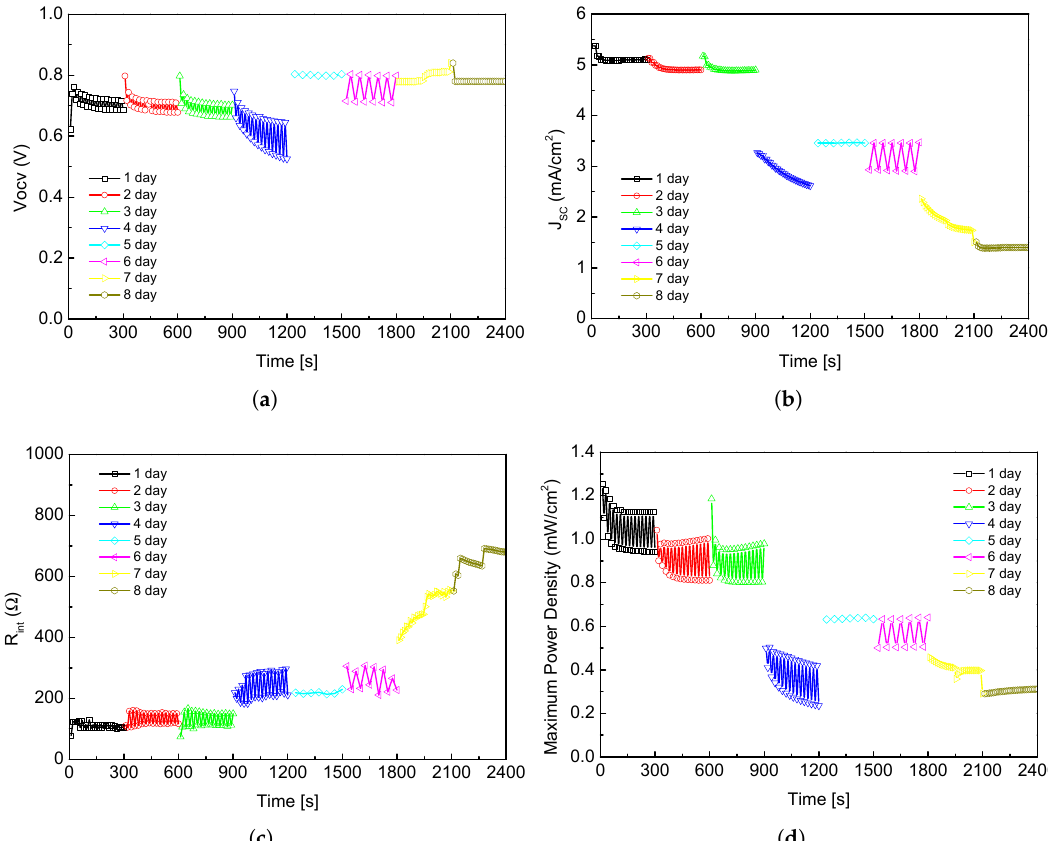
Figure 7. PMFC Cu/Zn performance comparative: ( a ) open circuit voltage; ( b ) short current density; ( c ) internal resistance; and ( d ) maximum power density.